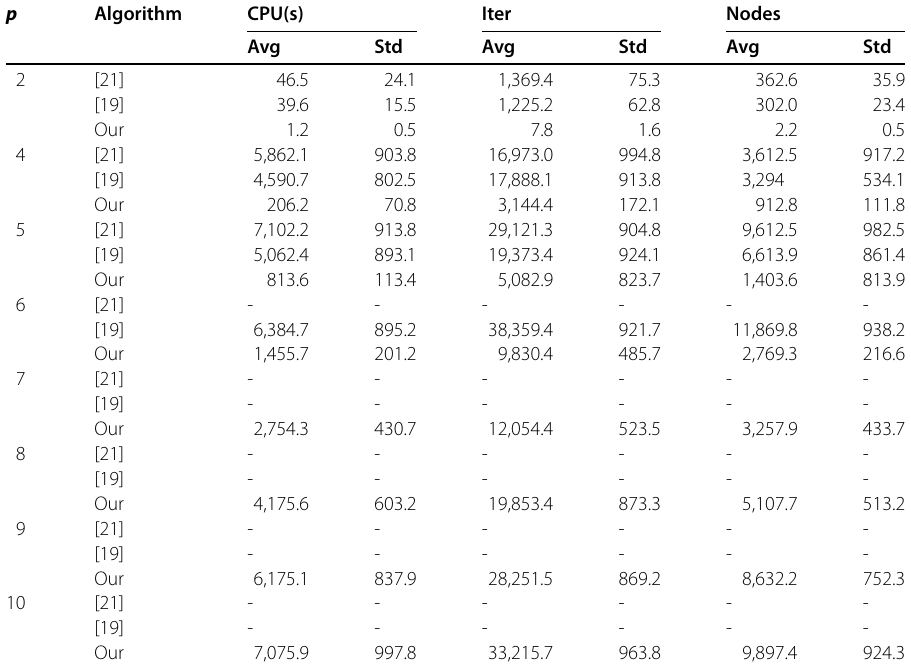
Table 2 Computational results of randomly generated test problems with ( m , n ) = (50,50)